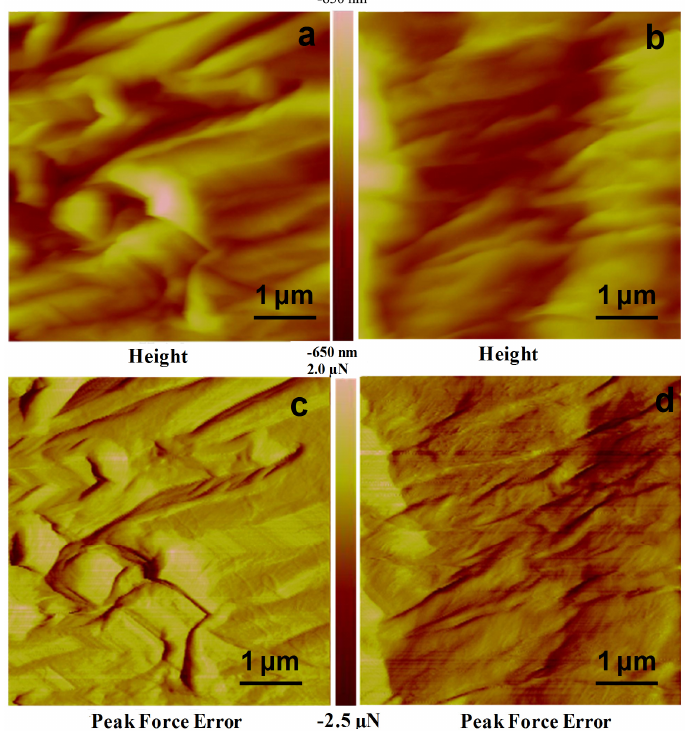
Figure 4. Atomic Force Microscopy (AFM) height and peak force error images (25 µm 2 ) of ( a , c ) chemically retted and ( b , d ) inorganic nanoparticle impregnated kenaf